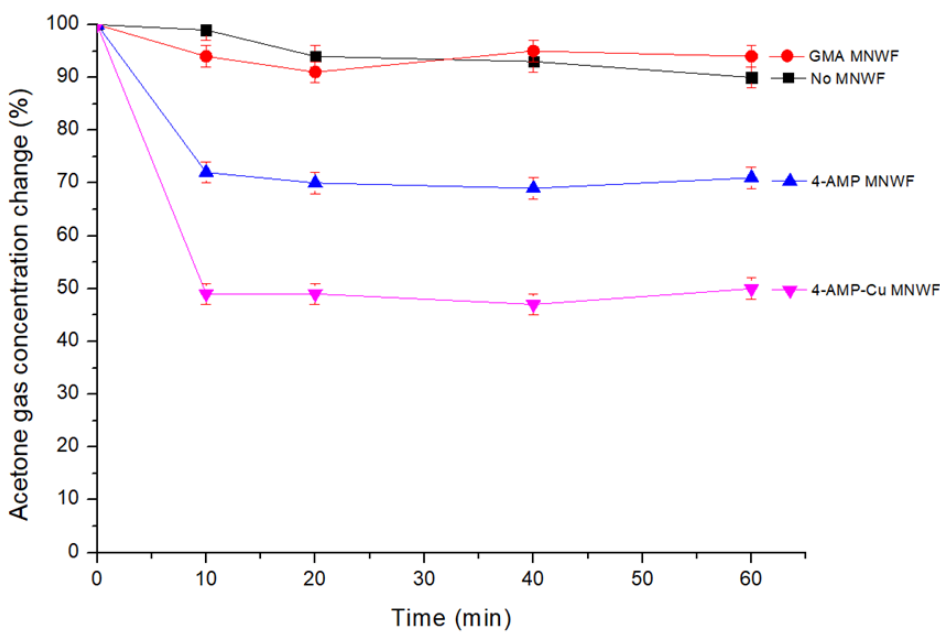
Figure 10. Acetone gas adsorption amount of each MNWF (about 50 ppm, dg 170% MNWF).